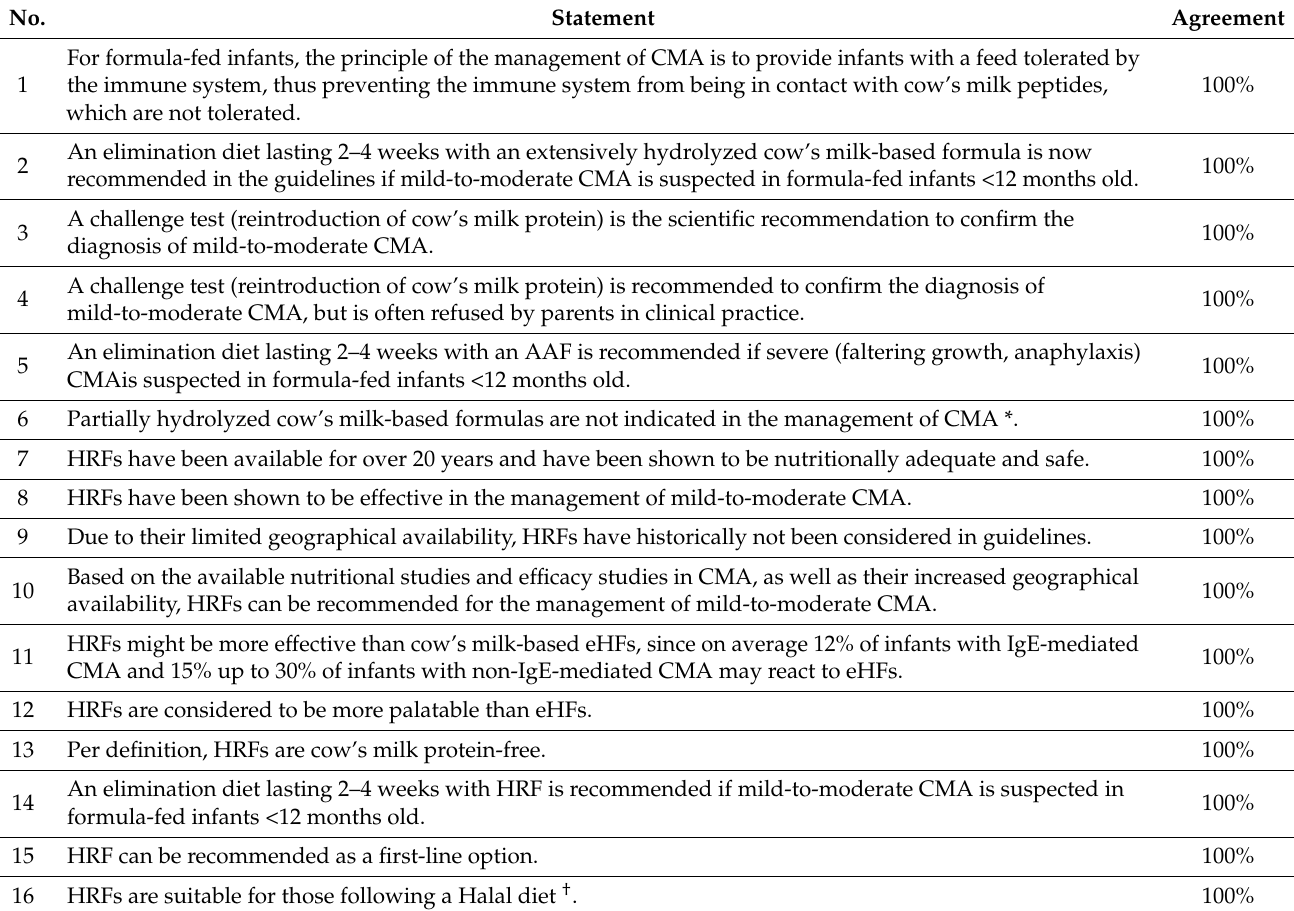
Table 2. MENAP consensus statements on the use of